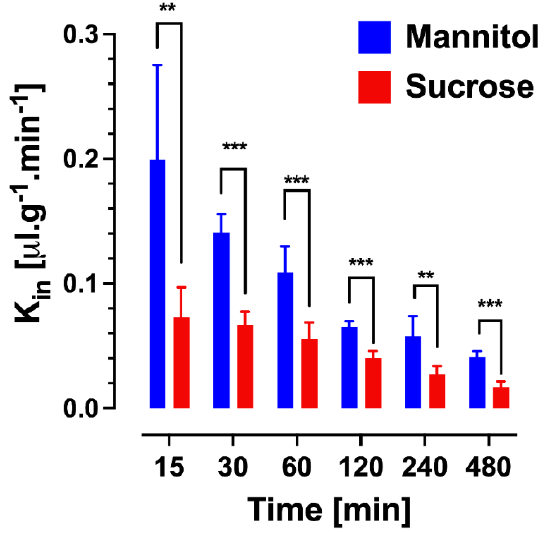
Figure 3. Single time point analysis of sucrose and mannitol brain uptake clearance values (K in ) at different time points from 15 to 480 min ( n = 4–7 animals per marker per time point). Sucrose and mannitol values at each time point were compared by t -test. ** p < 0.01, *** p < 0.001. Reprinted with permission from Reference [19]. Copyright 2022, Springer Nature.